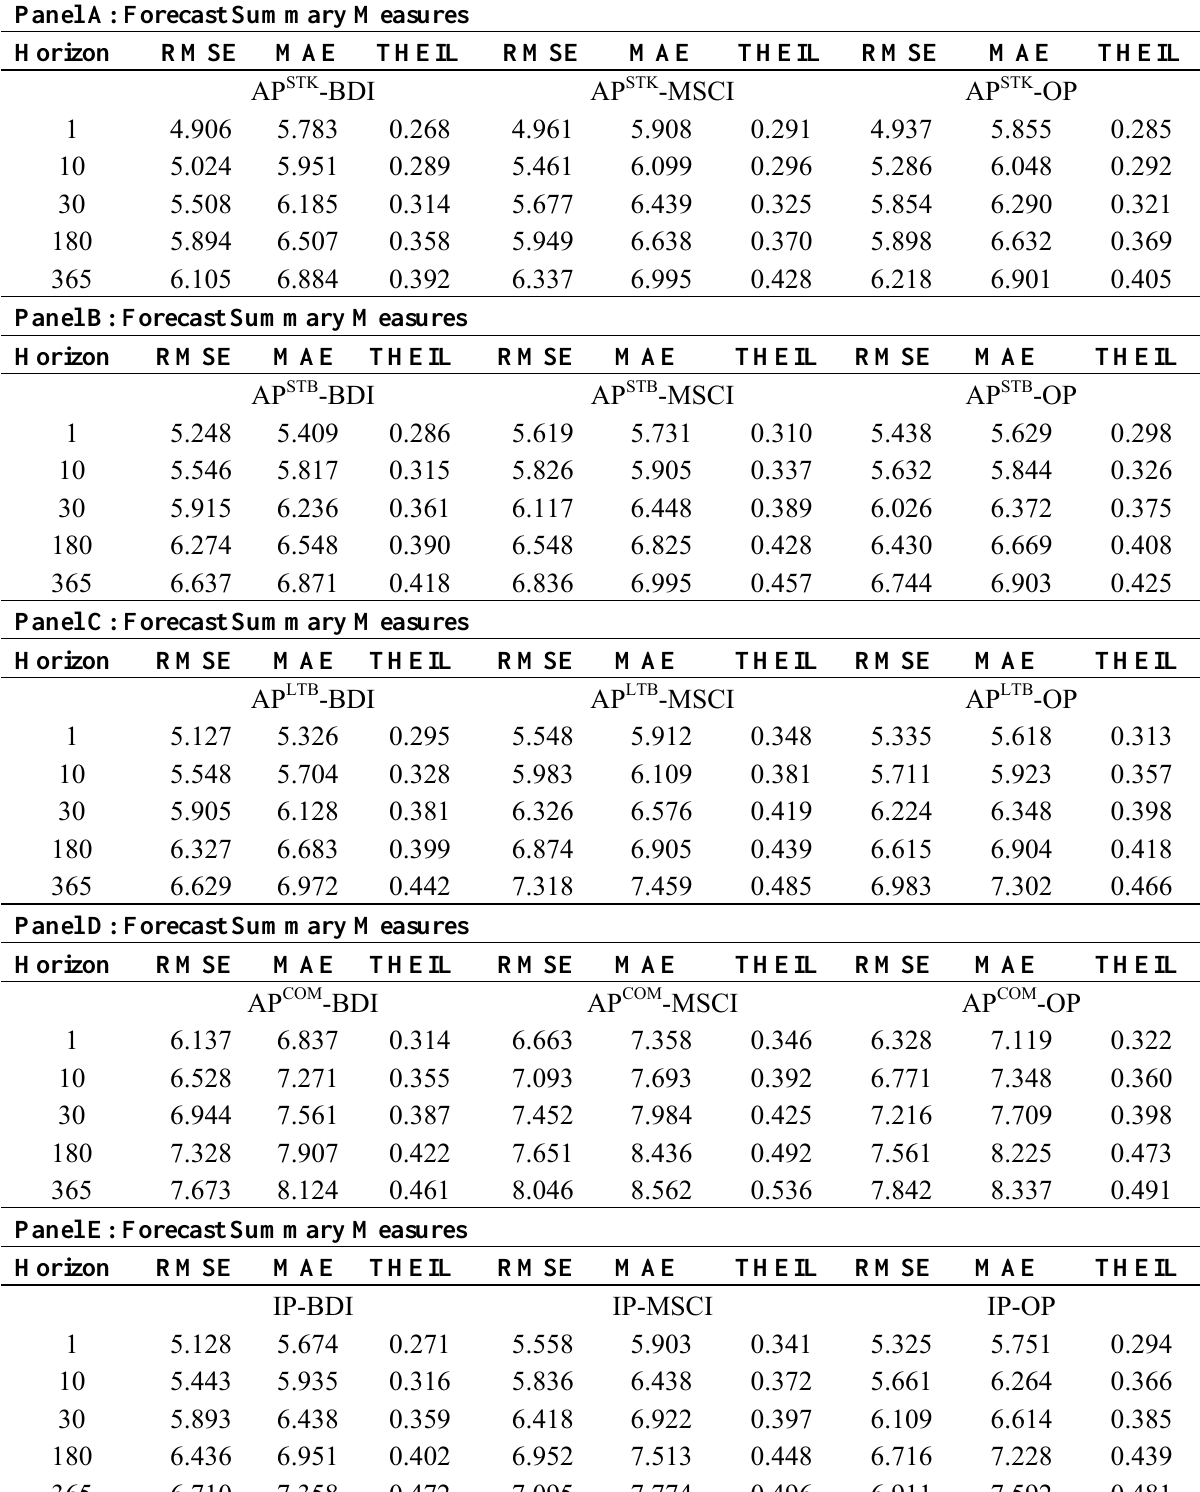
Table 8. Forecasting